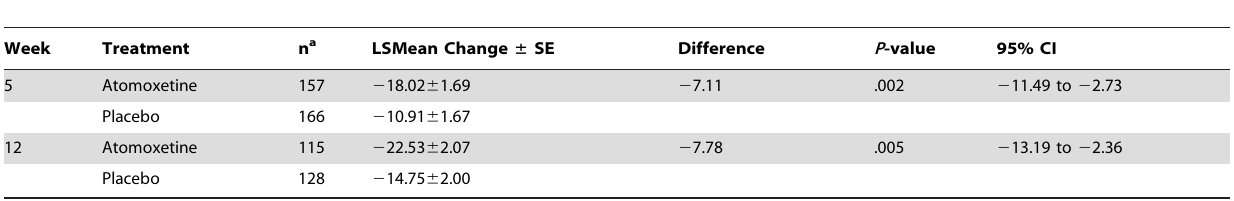
Table 4. BRIEF-A Mean Change from Baseline to Postbaseline Visits for All Randomized Patients – Repeated Measures Analysis for Global Executive Composite